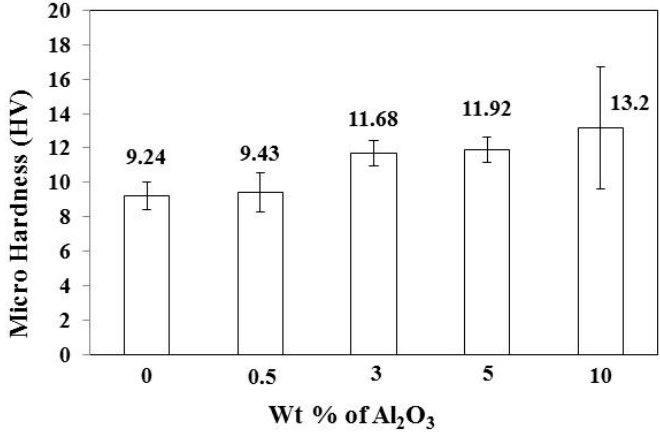
Figure 6. Variation of micro hardness of the pristine and the nanocomposite coatings.